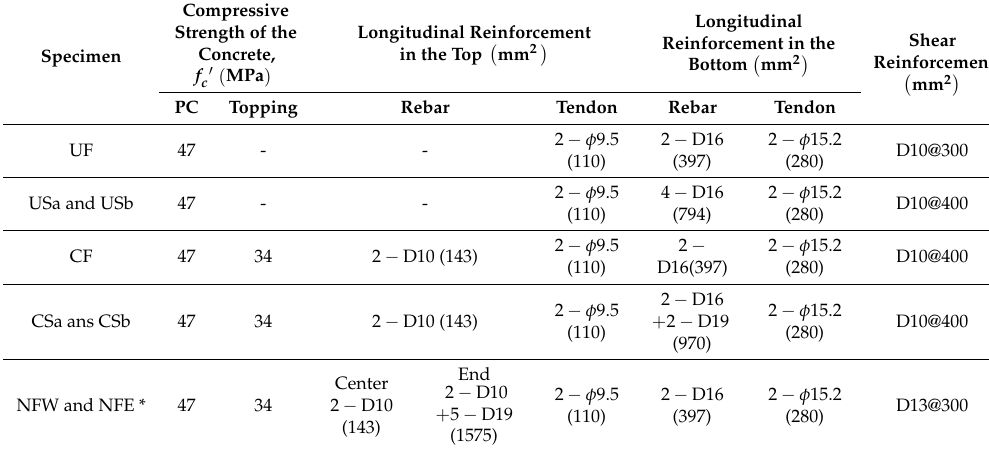
Table 1. Summary of specimens.